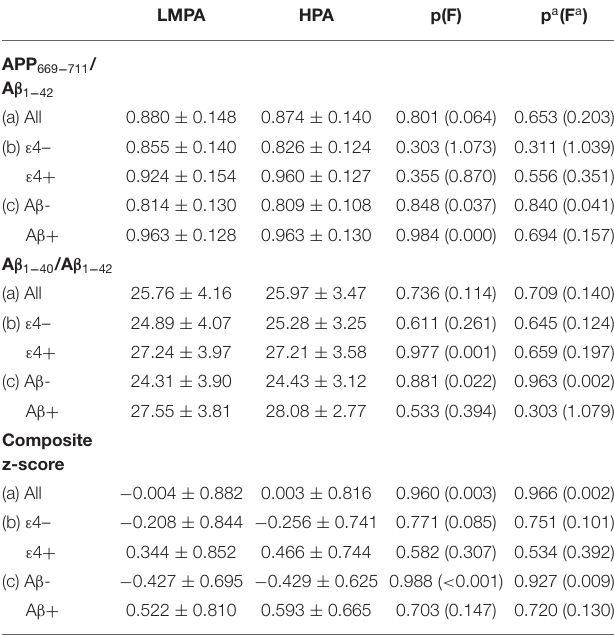
using general linear models. Brain amyloid deposition was measured using positron emission tomography. Plasma A β 1 − 42 data were natural log transformed to better approximatenormalityandvariancehomogeneity(#).p a (F a )representsp-valuesadjusted for age and sex. P < 0.05 (italic) was considered significant. Data are presented in mean ±